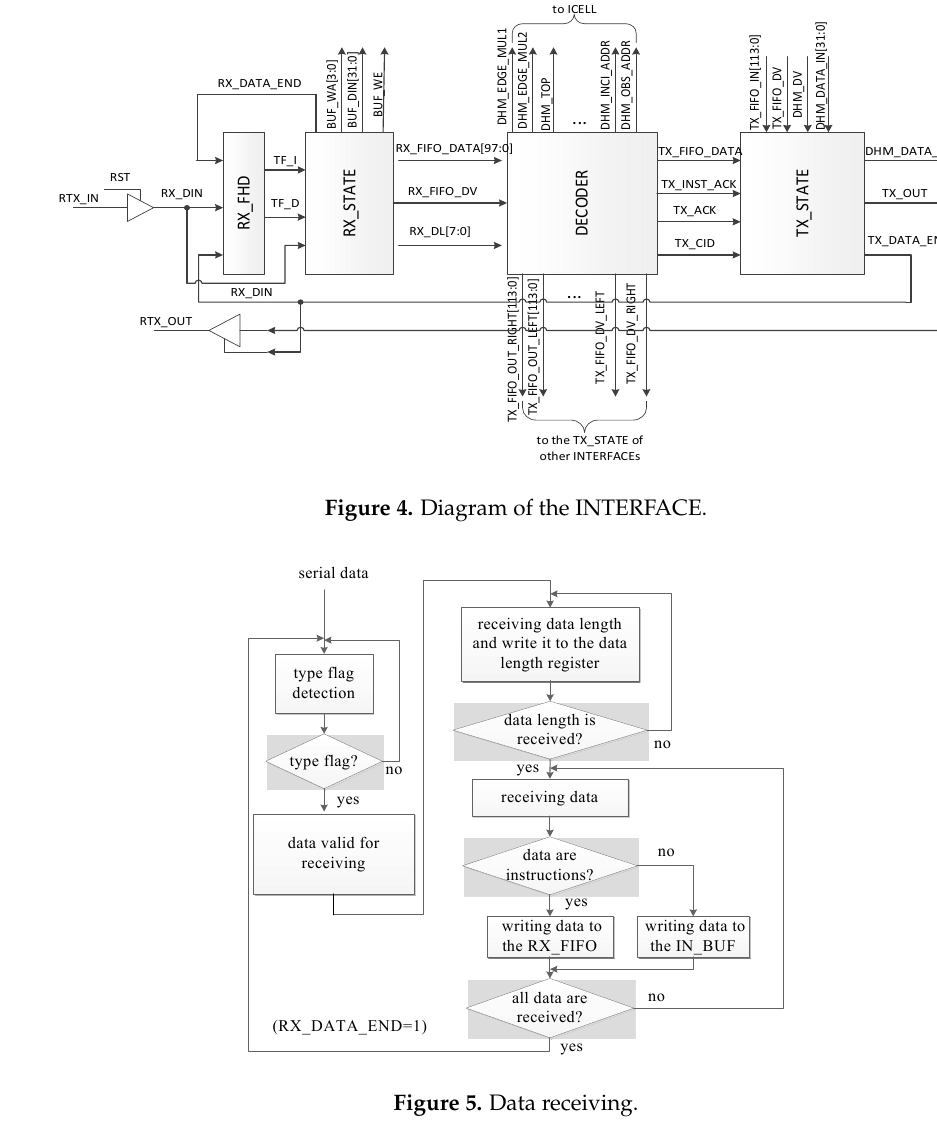
no Figure 6. Data transmission. 4. Performance Estimation To verify and estimate system performance, the register transfer level (RTL) model and cycle- accurate simulator of the processor were developed using VHDL and C programming language. Furthermore, the prototype machine was investigated and implemented using a processor-based FPGA machine TD-SPP3000 from Tokyo Electron Device Ltd., and sound propagation in a small shoe-box type room was examined. In the defined room, both length and width were 1.28 m, and height was 0.64 m; the cube grid size